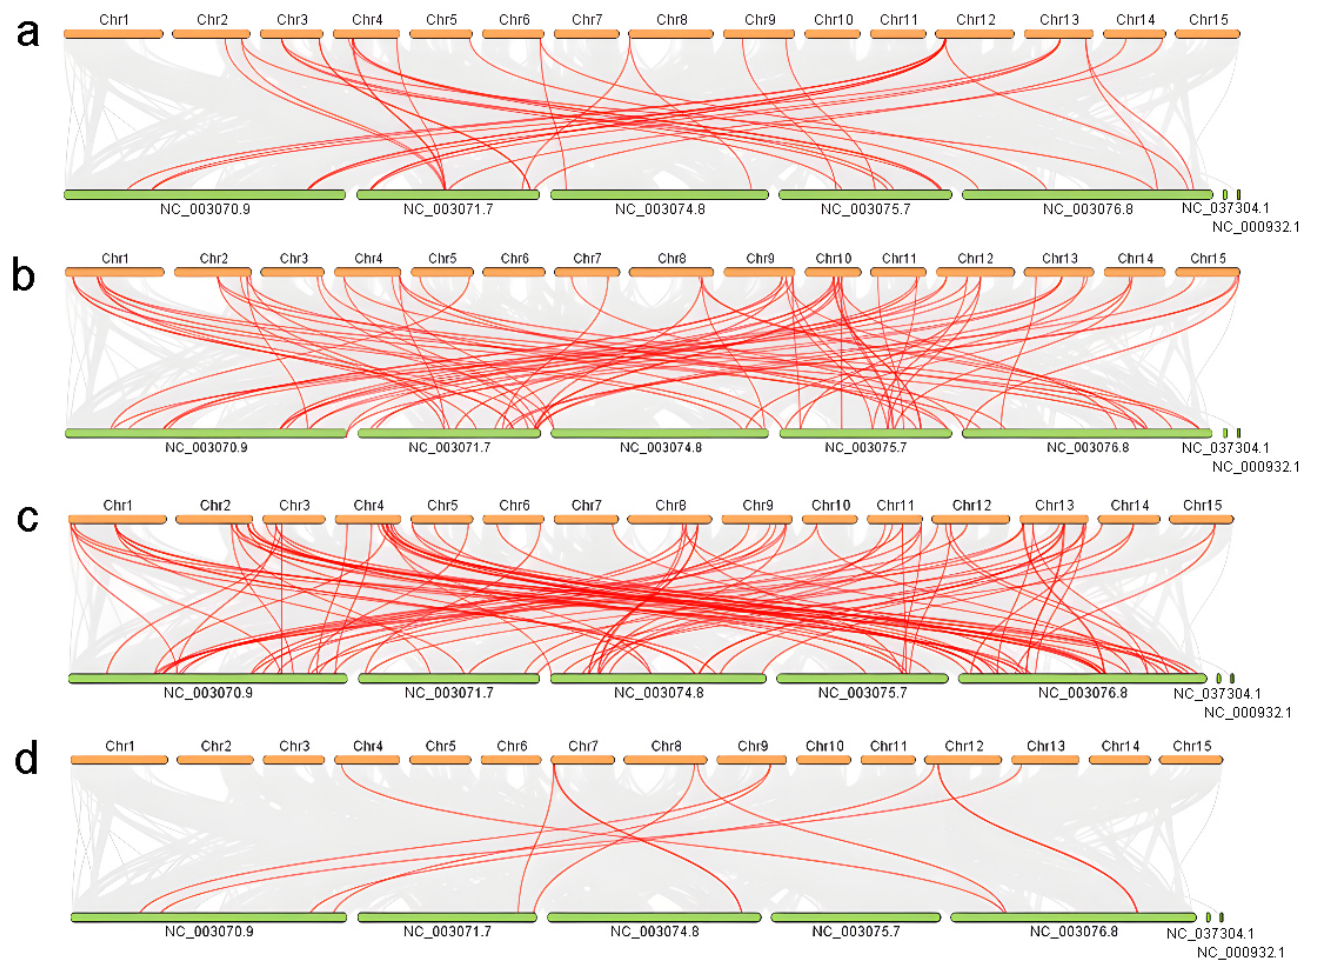
Figure 3. Orthologous relationship analysis of ( a ) MADS-box, ( b ) WRKY, ( c ) NAC, and ( d ) SBP-box genes in D. oleifera and Arabidopsis . Orange and green blocks present chromosomes of D. oleifera and Arabidopsis ,